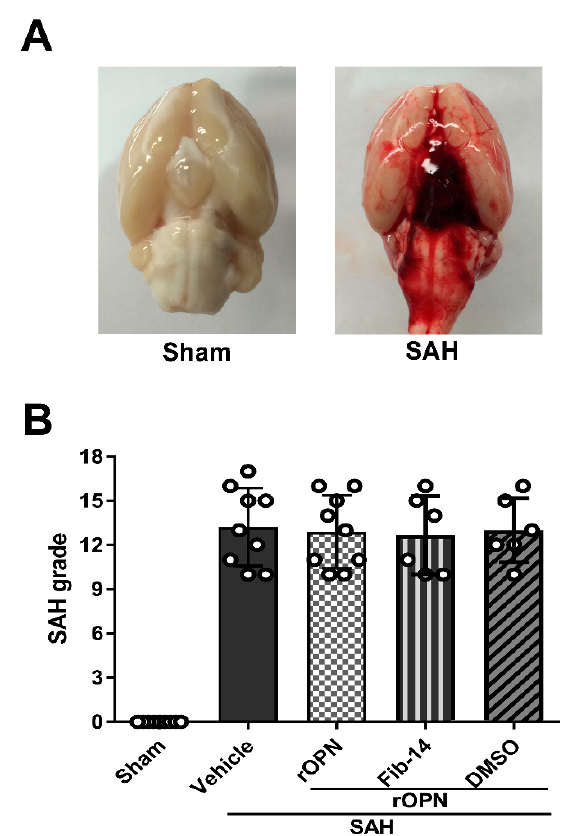
Figure 2. Analysis of subarachnoid hemorrhage (SAH) grades in all SAH groups. ( A ) Representative brain images of Sham and SAH rats. ( B ) Summary of SAH grading scores of all groups. SAH, subarachnoid hemorrhage; rOPN, recombinant OPN; Fib-14, FAK inhibitor 14; DMSO, dimethyl sulfoxide.